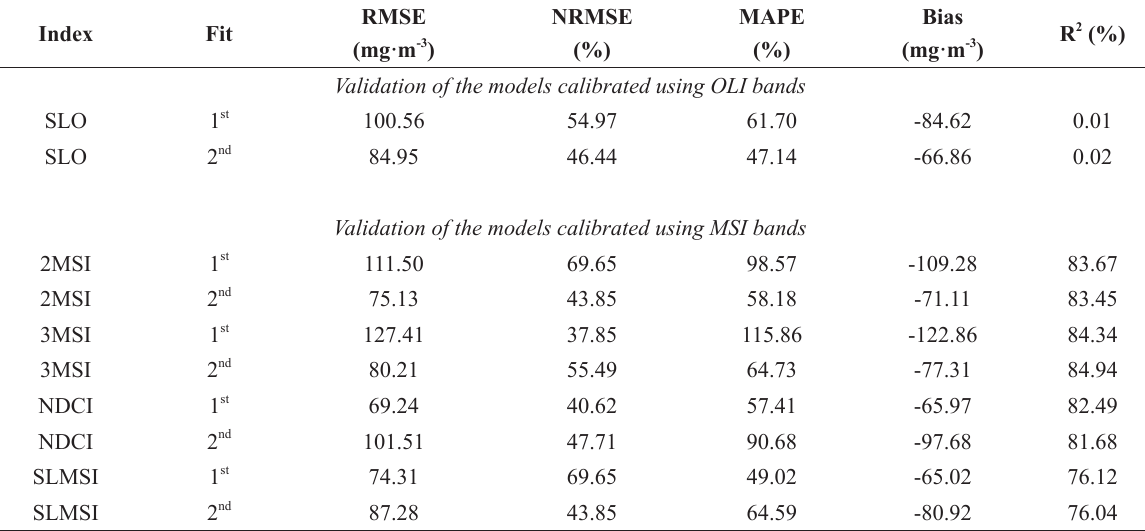
Validation of the models considering RMSE, NRMSE, MAPE, bias and R 2 for OLI and